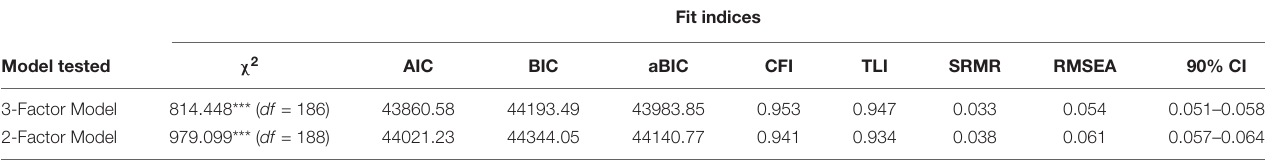
TABLE 3 | Summary of Goodness-of-fit Indices for CFA.